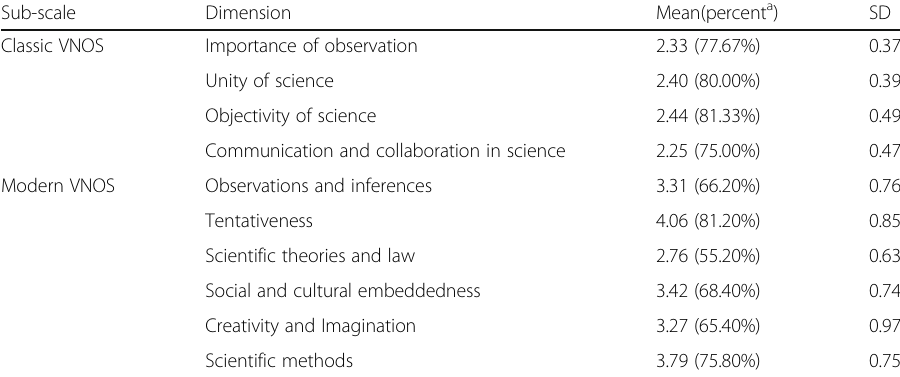
Table 3 Descriptive analysis of teachers ’ VNOS on each dimension